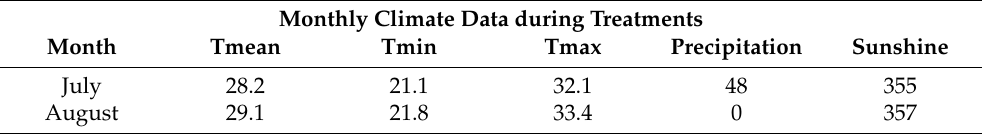
Table 1. Monthly climate data, during the experimental period. Monthly Climate Data during